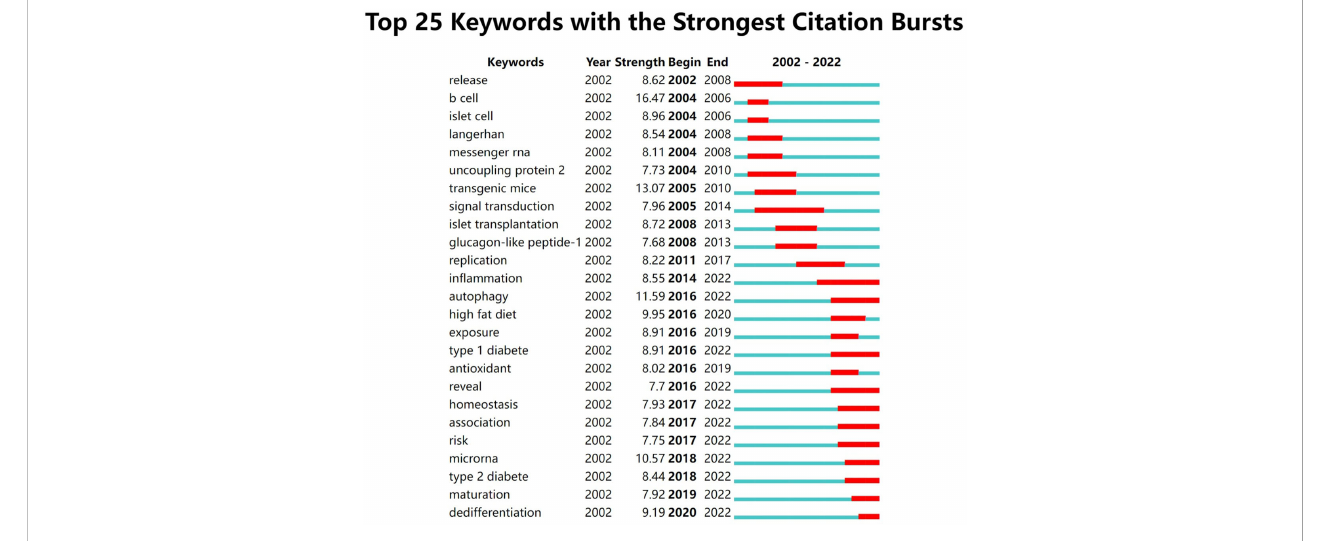
FIGURE 8 Top 25 keywords with the strongest citation bursts involved in beta-cell